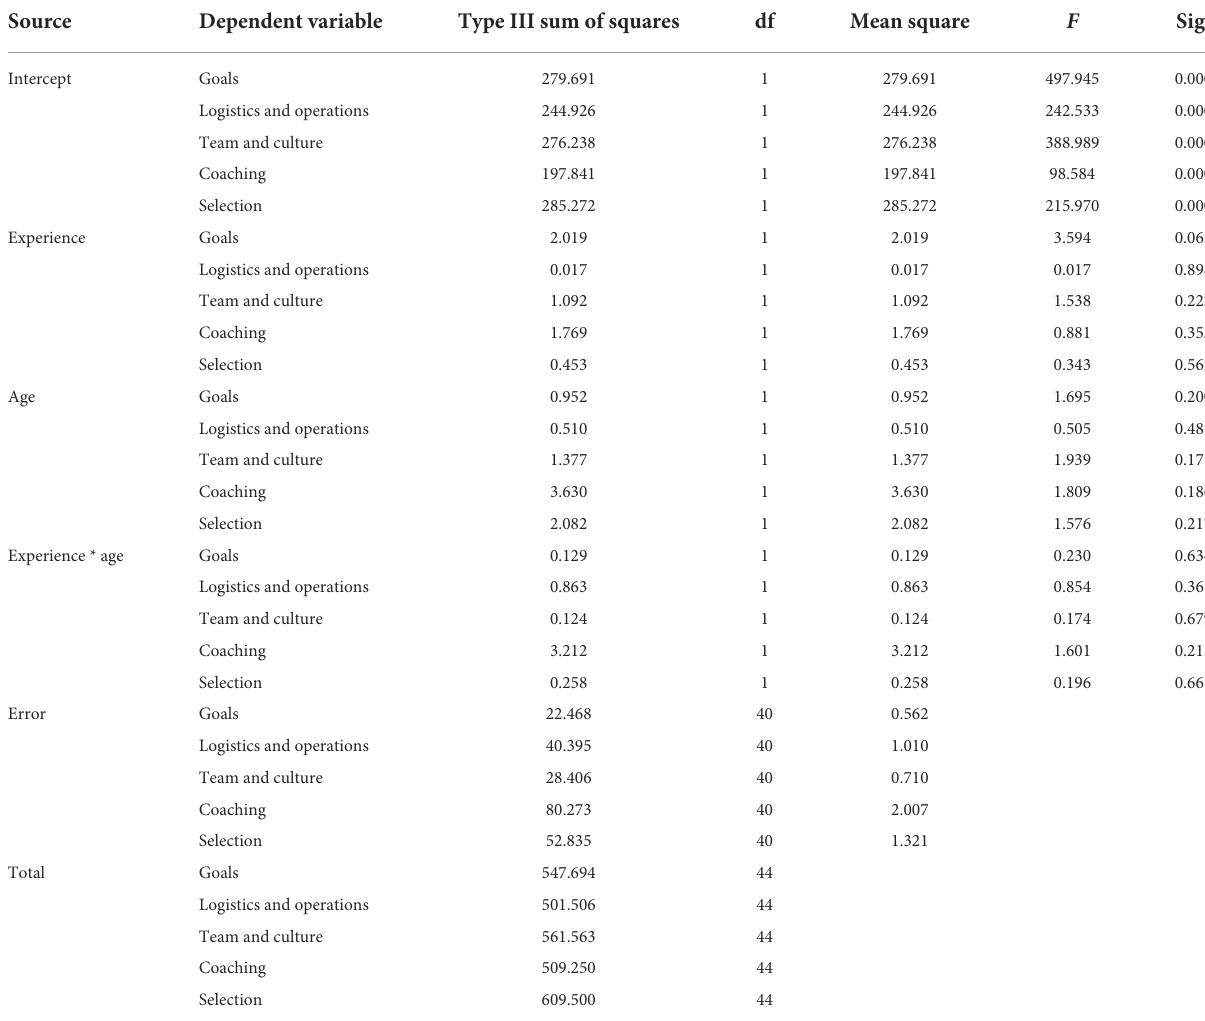
TABLE 5 Tests of between subject effects (univariate results) for coaches on the contribution of age and years of experience on organizational